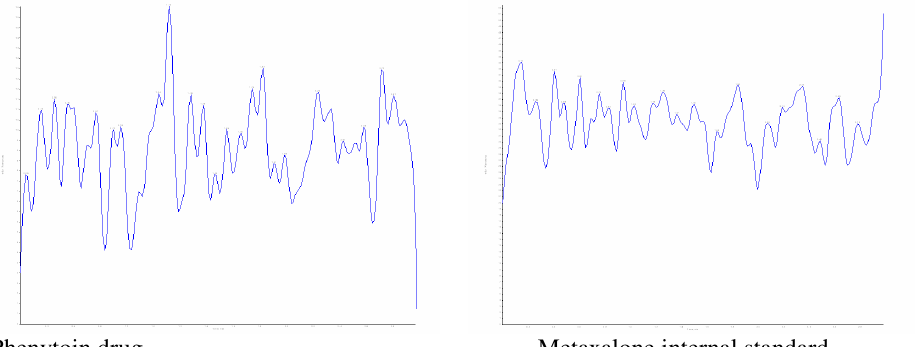
Figure 3a . Representative chromatograms of (A) Plasma blank for Phenytoin drug and Metaxalone internal